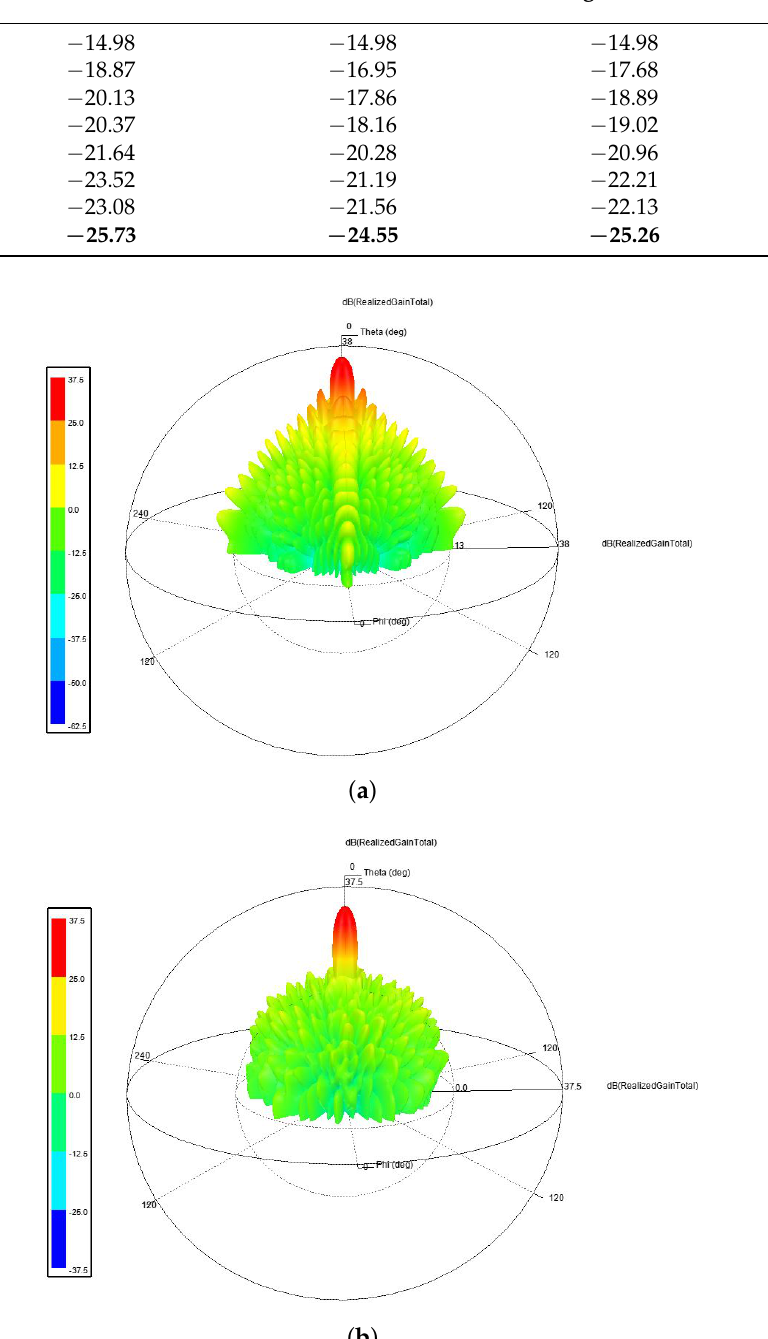
Figure 12. Three-dimensional EM simulation results. ( a ) 3D EM simulation results of the uniform 528-element Planar Phased Array; ( b ). 3D EM simulation results of the 528-element Planar Phased Array optimized with